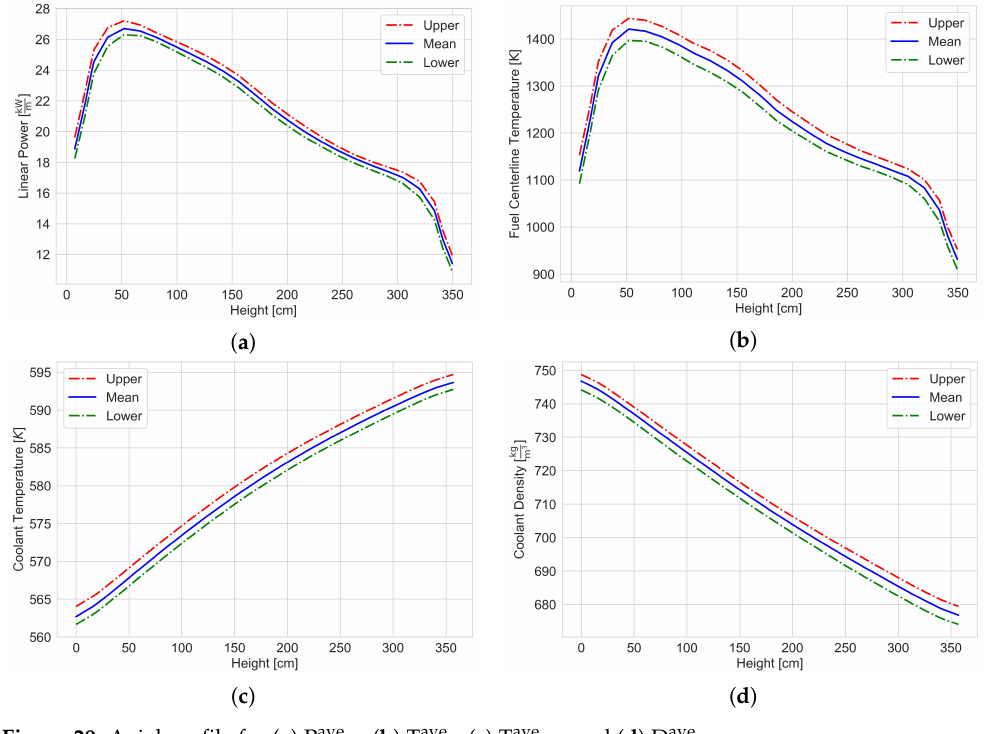
, ( b ) T ave , ( c ) T ave and ( d ) D ave lin,ax fc,ax cool,ax cool,ax